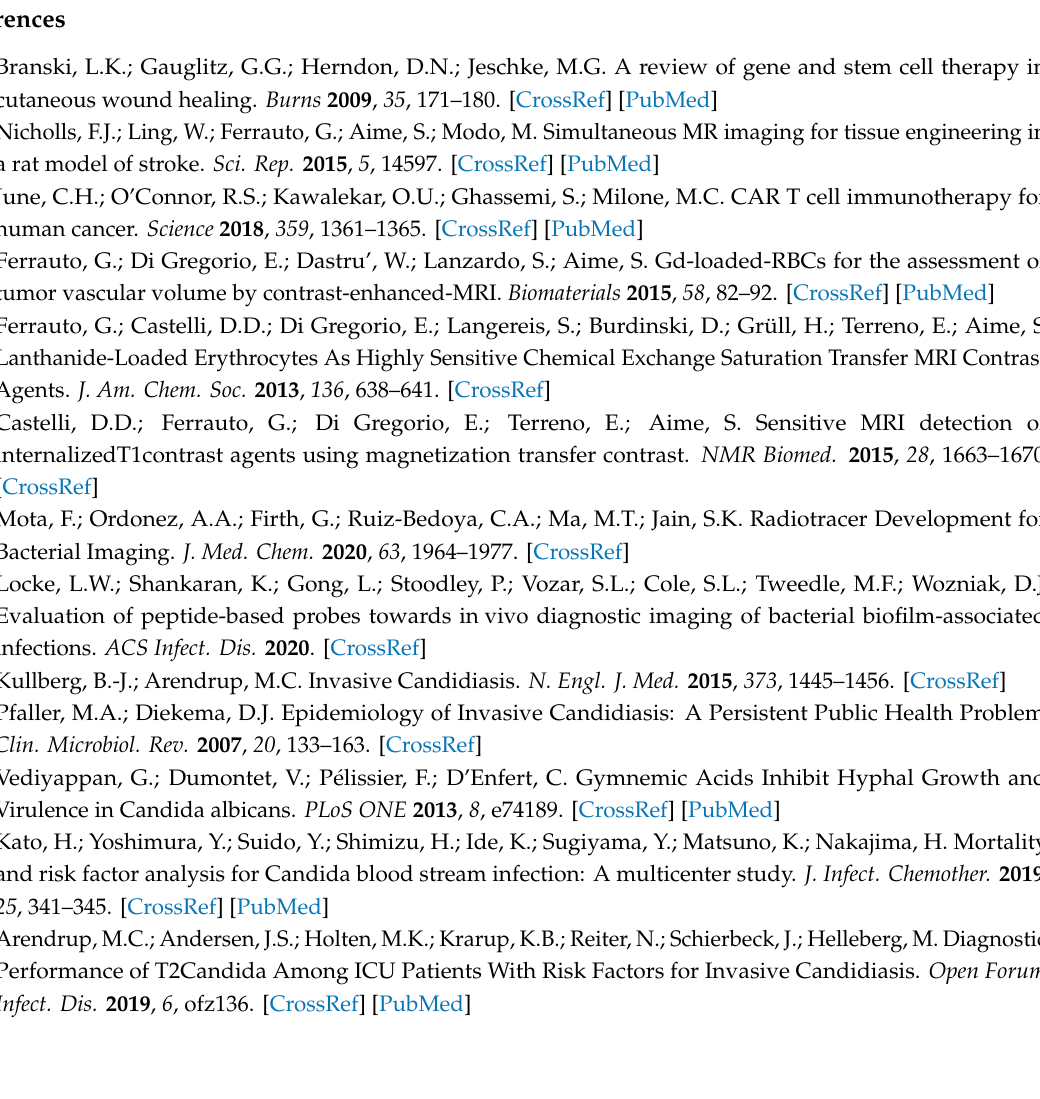
Figure S29: Serial dilution assay with C. albicans (hyphae) (i) untreated (ii) 10 mM Fe(TOB) treated (iii) 10 mM Maltol treated and (iv) 10 mM Fe(TOB) treatment followed by 10 mM Maltol treated cells spotted on YEPD media at 30 ◦ C. The cells were grown for 2 days and